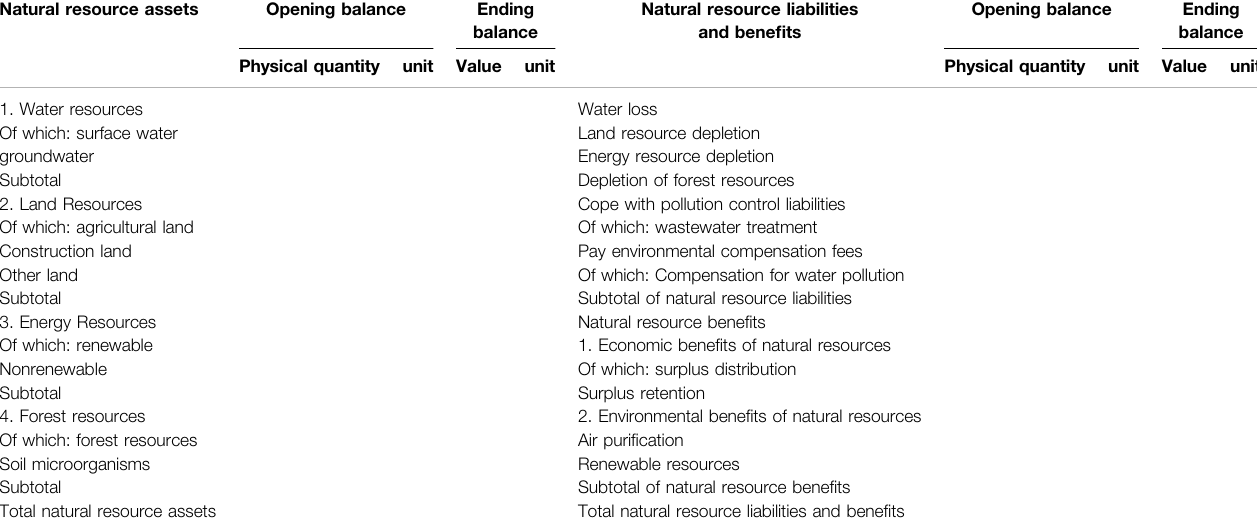
TABLE 3 | Natural resources balance